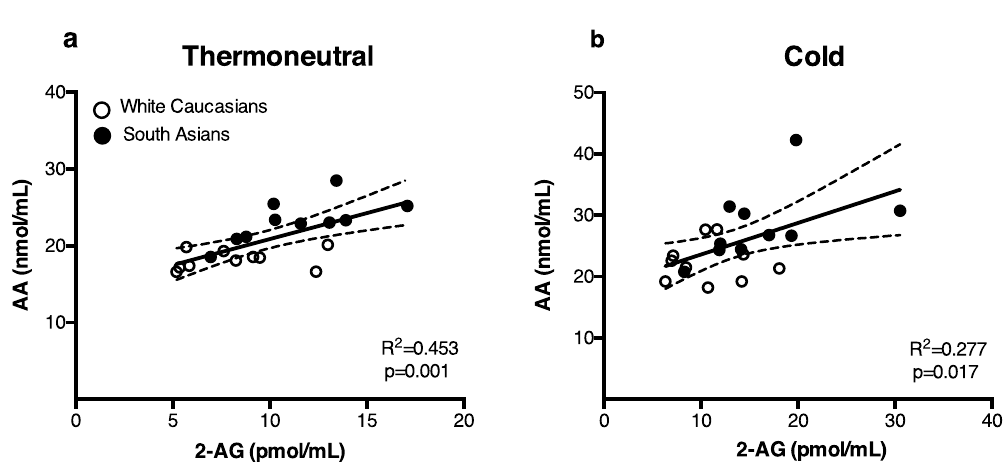
Figure 3. Plasma 2-AG levels correlate with plasma AA levels. Scatterplot of the correlations between plasma 2-AG and AA in both Caucasian and South Asian individuals (n = 40). Correlation is shown for the total group combined under thermoneutral ( a ) and cold conditions ( b ), black circles are South Asian individuals and white circles are white Caucasian individuals, with 95% confidence limits. Correlations were analysed using linear regression